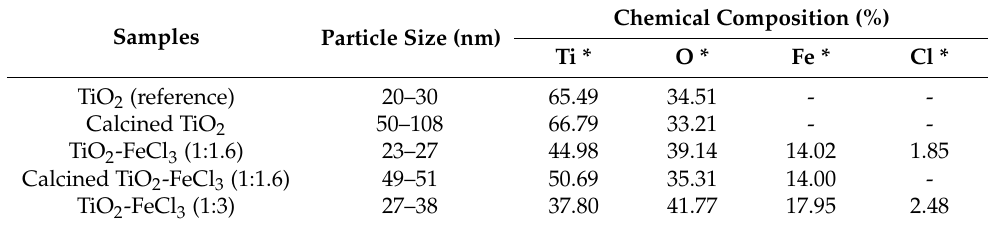
Table 2. Particle size variation and characterization of each sample studied.